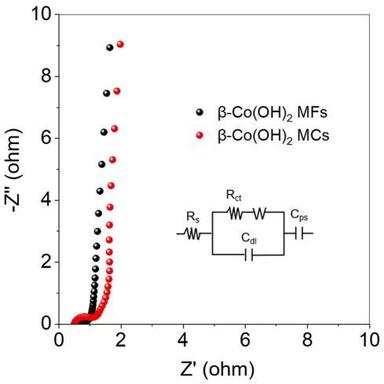
Nyquist plots of both β-Co(OH)2 microflowers and microclews with a simulated equivalent circuit in the inset.